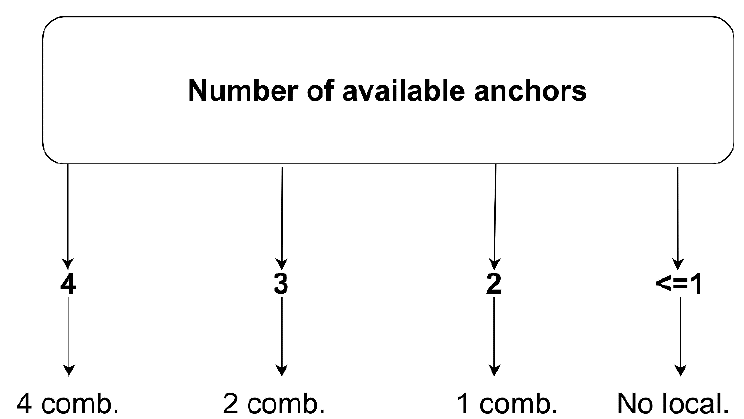
Figure9. Figure 9. The number of combinations of anchor pairs used in localization under the geometrical method.